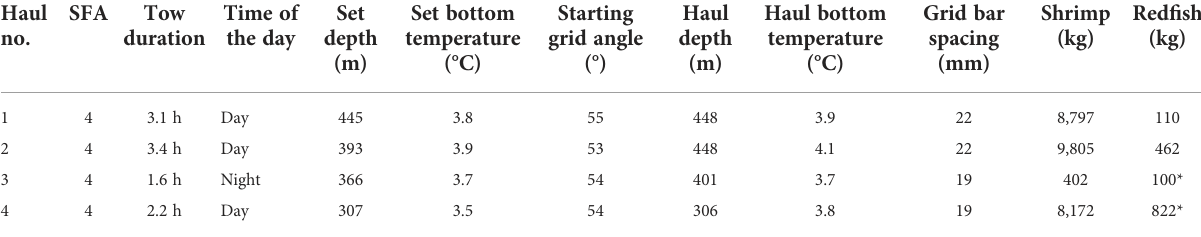
TABLE 1 Information on the video recorded tows used in the video analysis. Haul no.